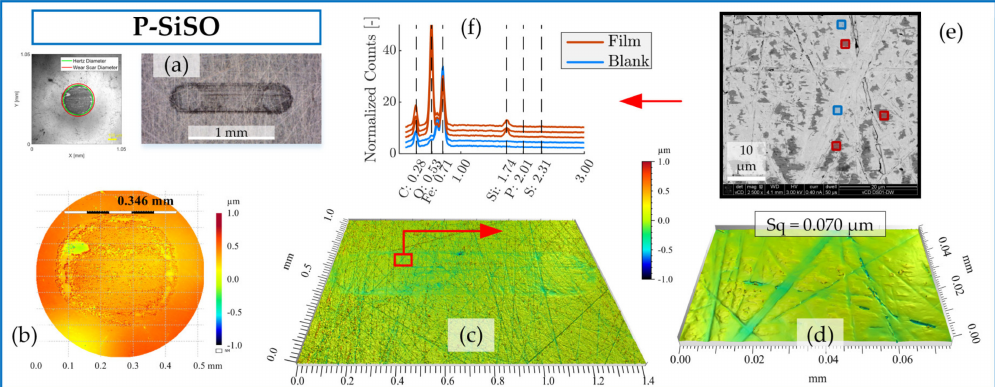
Figure 8. Surface analysis of SRV-3 steel samples lubricated with neat P-SiSO under conditions {150 N/2.4 GPa/AIR}. ( a ) Overview of ball and disc wear scars. ( b ) Detailed view of ball wear scar topography as seen by 3DP with 10 × objective (curvature removed). ( c ) Disc wear scar topography seen by 3DP using 10 × objective and ( d ) detail at 50 × objective. ( e ) SEM-EDS analysis of region corresponding to topography in ( d ). ( f ) EDS spectra of regions of